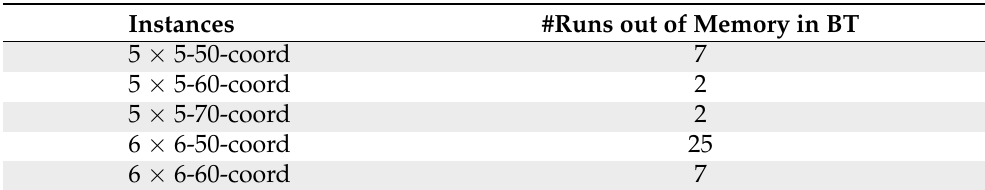
Table 5. Number of runs that reached the memory limit within the background theory in the coordinated